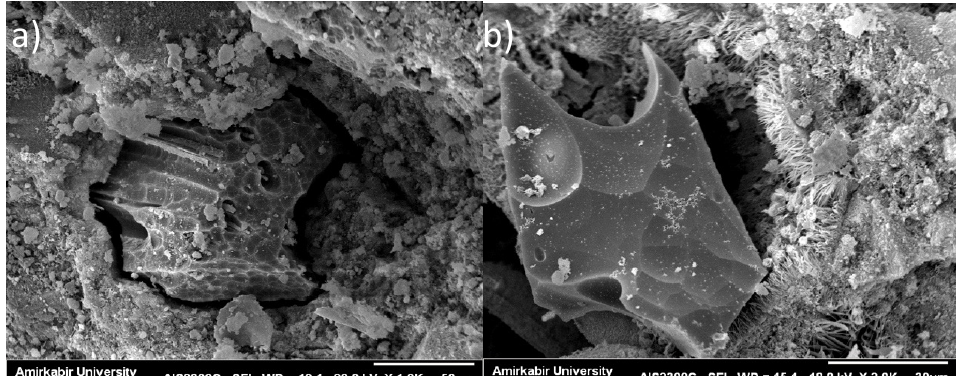
Figure 6. SEM images of: ( a ) CO sample; and ( b ) MK30 sample.